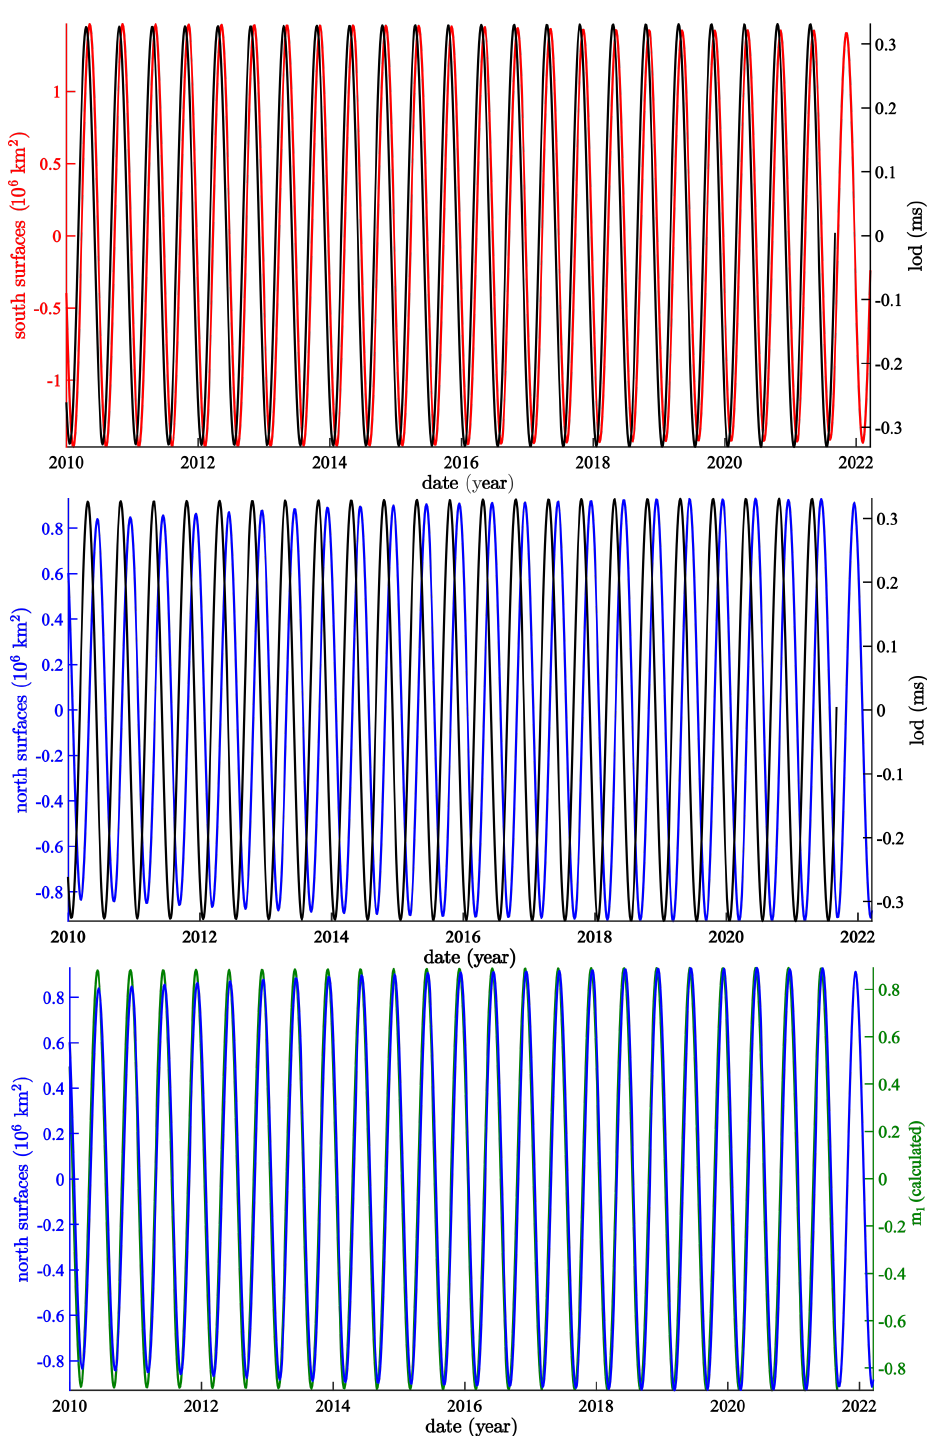
Figure 9. Comparison of SSA semi-annual components of pole motion m 1 ( bottom , in arc seconds) and lod ( top and middle in ms) with those of NHSI ( middle and bottom , Arctic sea-ice in 10 6 km 2 ) and SHSI ( top , Antarctic sea-ice in 10 6 km 2 ) for 2010–2022; m 1 in the lower frame is not observed, but is computed by integrating lod (see